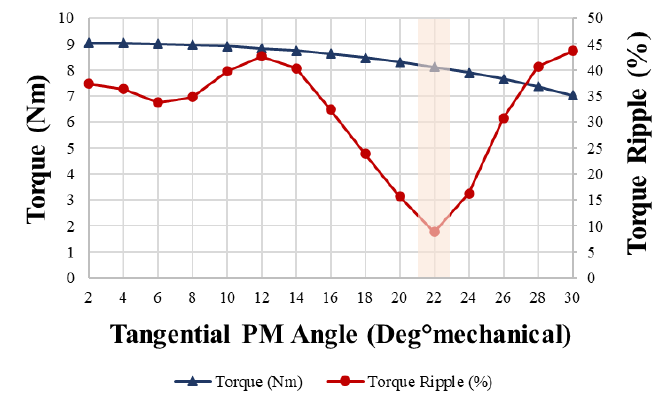
Figure 12. Torque and ripple according to tangential PM angle.